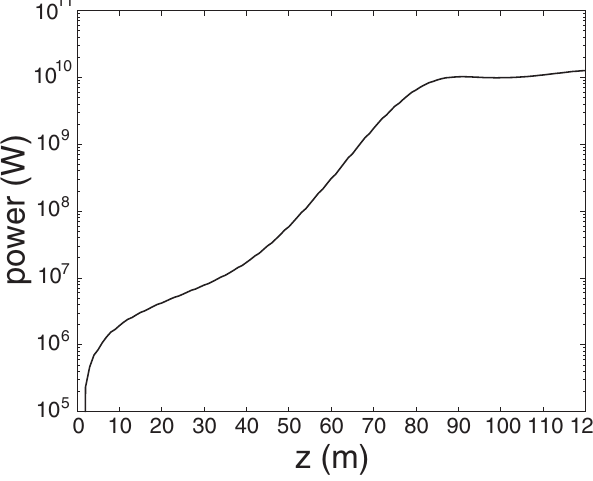
FIG. 8. GENESIS SASE simulation of the LCLS power along the undulator